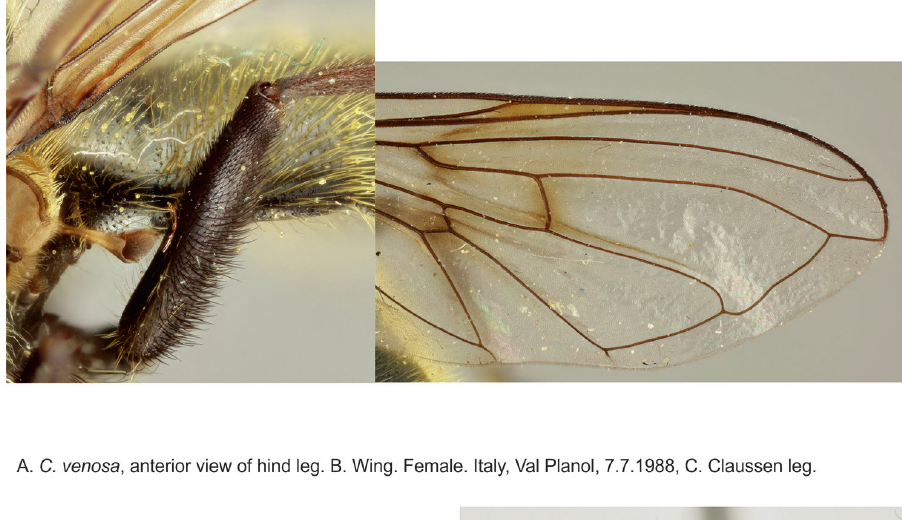
dark-brown to blackish. Antennal pits confluent (occasionally only narrowly conflu- ent). Vertical triangle with black pile. Eye-contiguity nearly equal to length of frons without lunula. Basoflagellomere small, rounded, brown to reddish brown. Arista short, thickened, clearly pubescent (Fig.